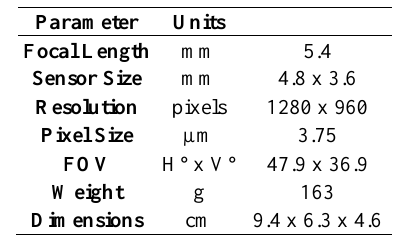
Table 1: MicaSense RedEdge-M specifications